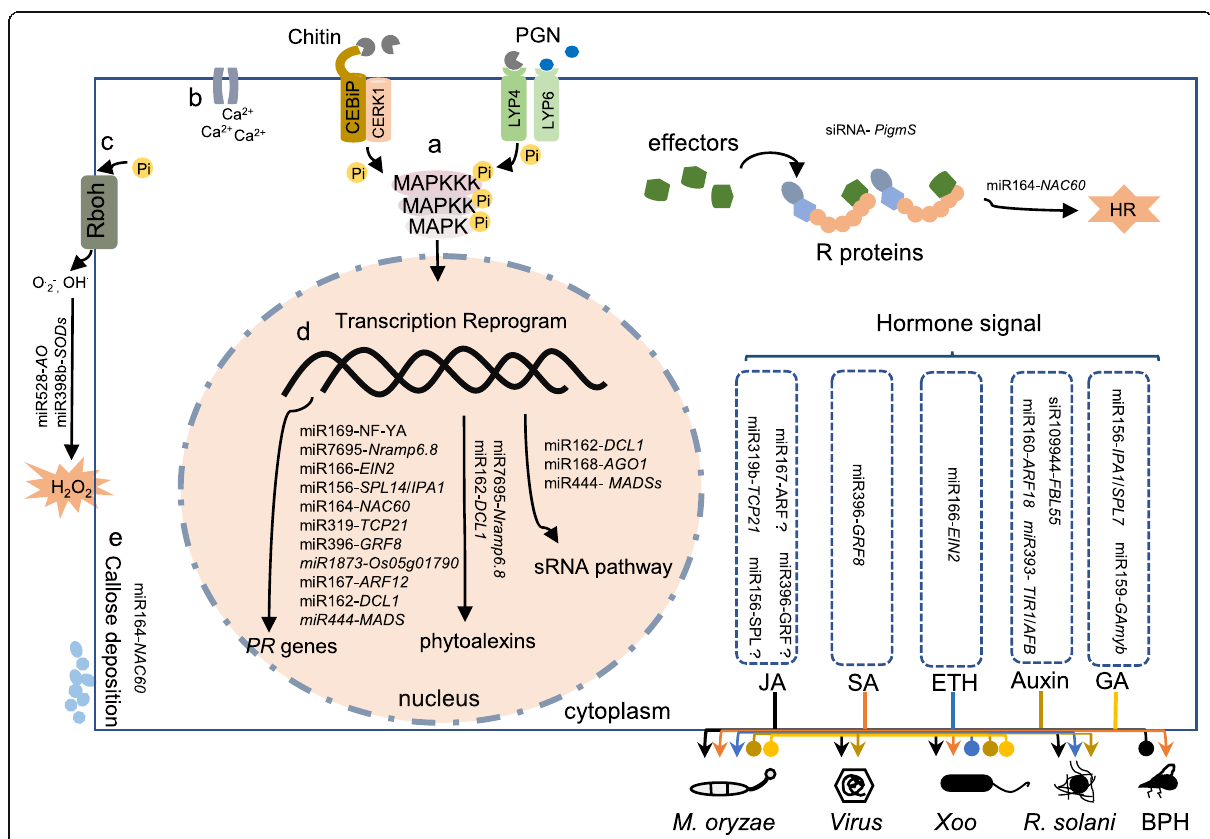
Fig. 2 Small RNA regulatory modules in PTI, ETI, and hormone signal pathway. PAMPs derived from fungi or bacteria, such as chitin or peptidoglycan (PGN), are recognized by the pattern-recognition receptors (i.e. CEBiP and CERK1, or LYP4, and LYP6) to activate PTI responses including: a ) activation of MAPK cascades, b ) calcium influx, c ) ROS burst, d ) the induction of PR genes and phytoalexins genes, and e)